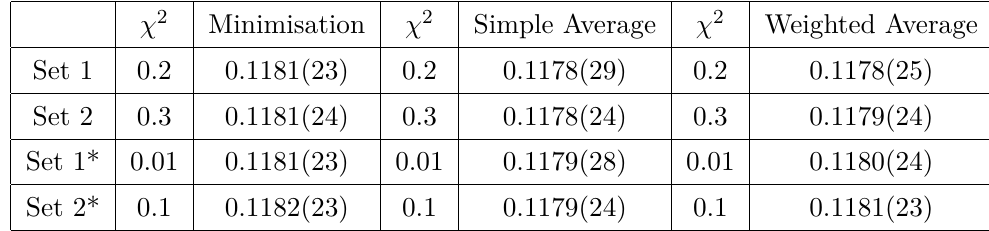
) obtained when the theory uncertainties from scale Z